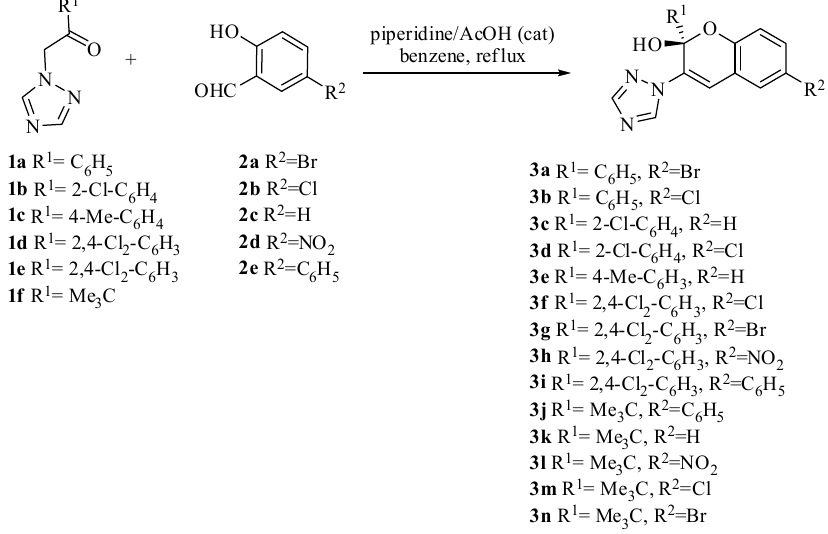
Figure 3. Synthesis of 1 H -1,2,4-triazole functionalized chromenols. The reaction of 1-(alkyl/aryl)-2-(1 H -1,2,4-triazole-1-yl)ethanones 1a – 1f with